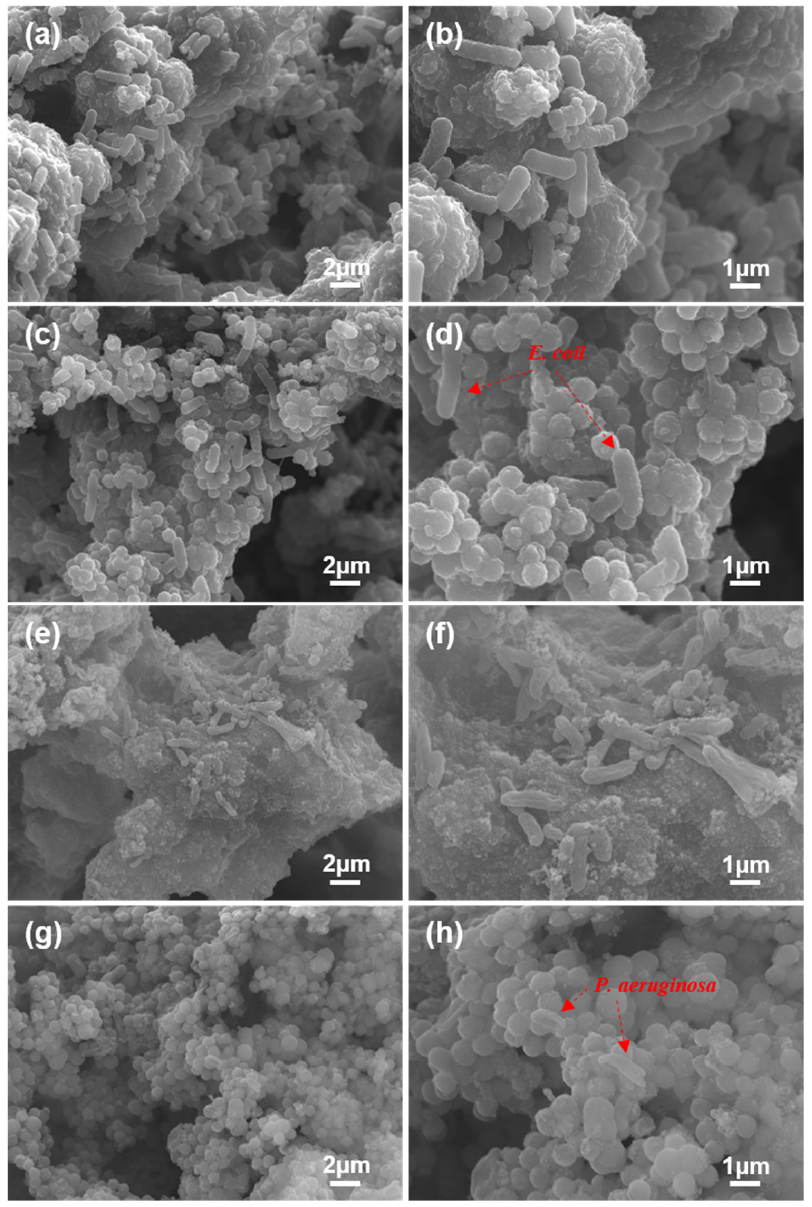
Figure 11. Surface SEM morphologies of the ( a , b ) SS and ( c , d ) SNC after 3 days of immersion in the E. coli -inoculated media; surface SEM morphologies of the ( e , f ) SS and ( g , h ) SNC after 3 days of immersion in the P. aeruginosa -inoculated media.